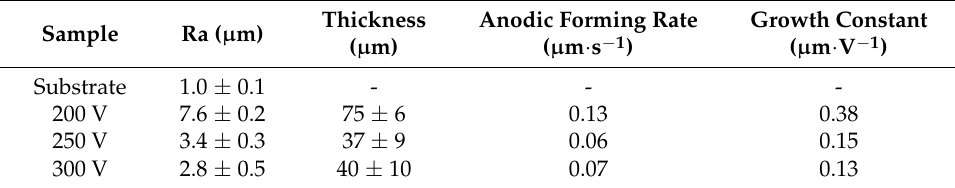
Table 2. Physical characteristics of the PEO coatings.